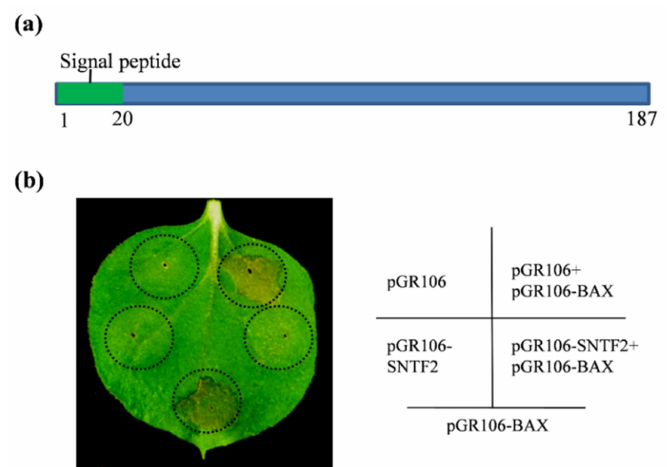
Figure 1. Sntf2 suppressed BAX-triggered cell death in Nicotiana benthamiana . ( a ) The structure analysis of Sntf2. Sntf2 was predicted to contain an N-terminal signal peptide (1–20 aa). ( b ) The tobacco leaves infiltrated with Agrobacterium tumefaciens GV3101 harboring the pGR106 vector or the vector with SNTF2 inserted. The A. tumefaciens carrying the BAX gene were injected into the leaves after 24 h post-infiltration. The empty pGR106 vector was used as the control. The black dotted lines indicate the region of infiltration. The diagram on the right shows the transformant strains of A. tumefaciens (containing recombinant pGR106 vectors) that was injected inside the black dotted lines. Images were acquired at 7 days post-infiltration. The experiments were repeated six times.